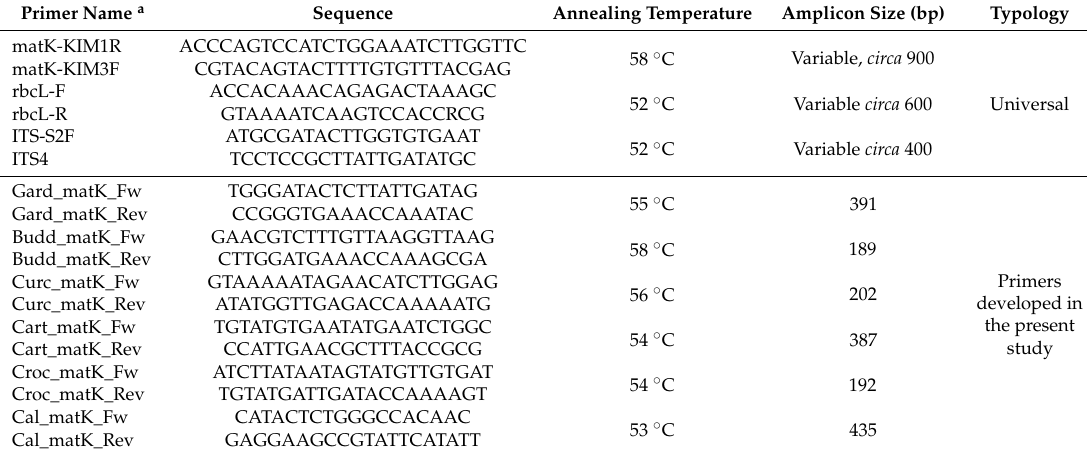
Table 2. Details of species-specific primer pairs used for the amplifications in this study. Universal primers are divided from the primers developed in the present study with a line.